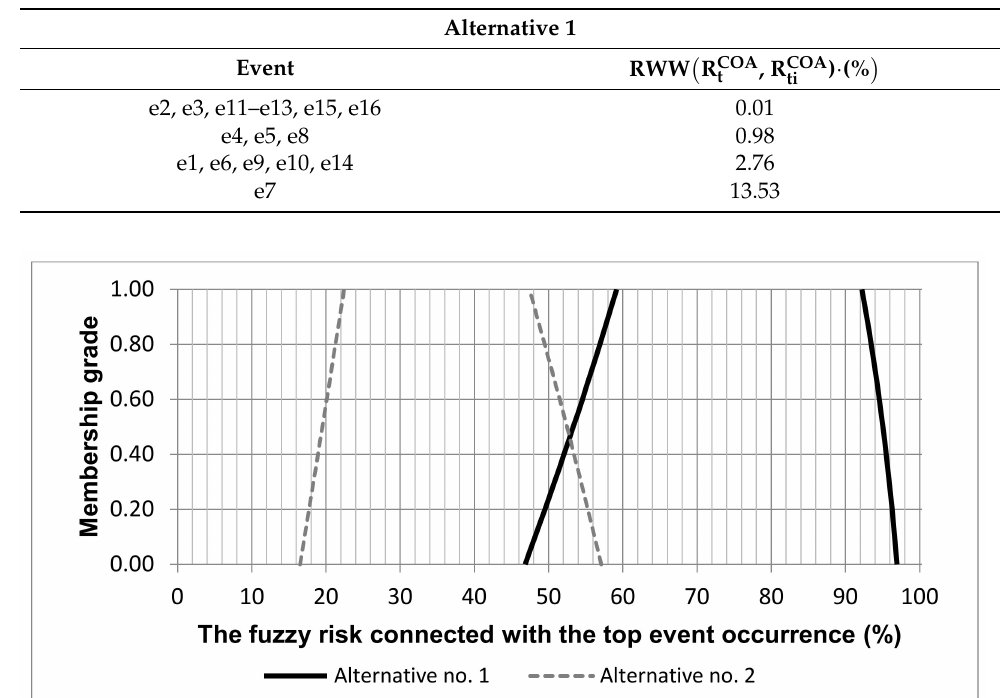
Table 9. Fuzzy weighted Index values for BEs and UEs calculated for Alternative 1.